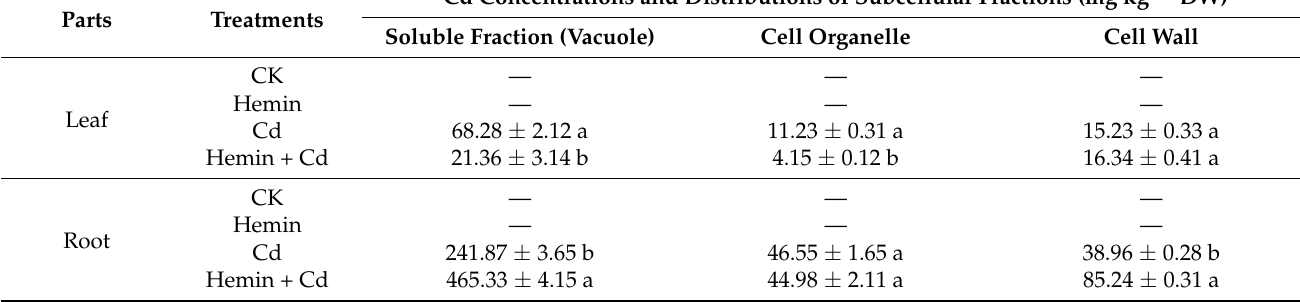
Table 6. Effects of hemin on subcellular distribution (soluble fraction, cell organelle, and cell wall) of Cd in roots and shoots under Cd stress.